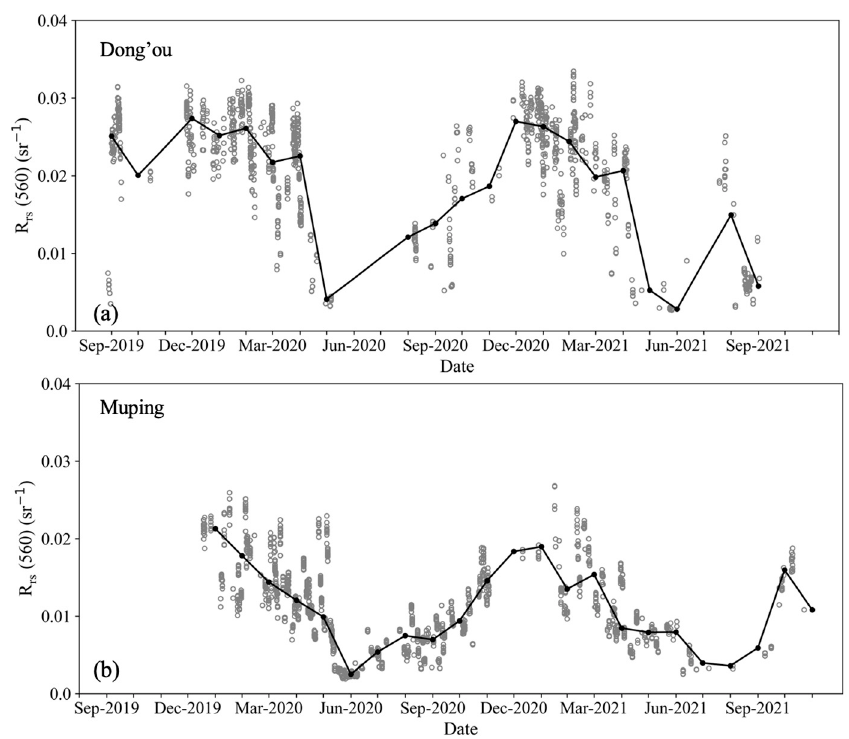
Figure 12. SeaPRISM-measured time-series remote sensing reflectance ( R rs ) at 560 nm at the ( a ) Dong’ou and ( b ) Muping sites. The grey dots represent all valid R rs measurements and the black dots are the monthly mean values.